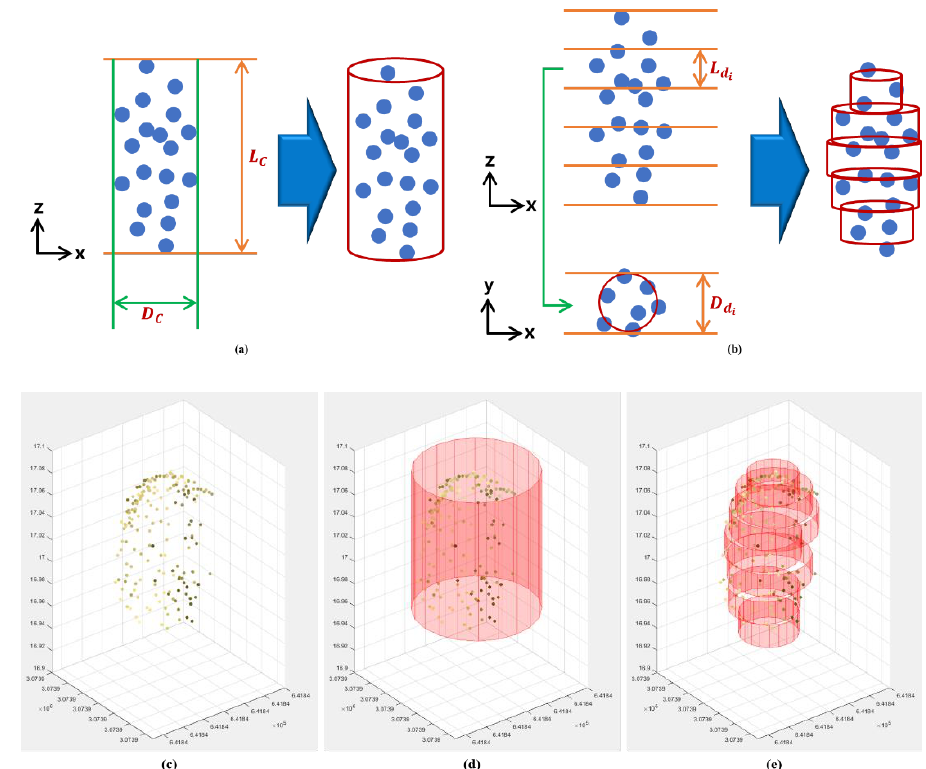
Figure 3. Schematic for calculating individual panicle volumes using ( a ) the cylinder-fitting method, and ( b ) the disk-stacking method; and an example showing ( c ) individual panicle points selected using RGB color and panicle volume estimated using ( d ) cylinder fitting and ( e ) disk stacking.